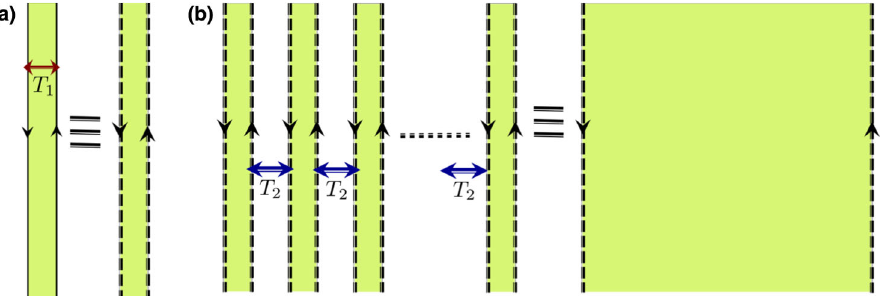
FIG. 3. Array of coupled 1D chain. (a) T 1 represents the intrachain interaction that turns a chain into a parafermion chain. The solid (dashed) line denotes a free-boson (parafermion) gapless mode. (b) T 2 represents the interchain coupling that gaps out every two adjacent parafermion modes. After applying the T 1 and T 2 terms, we are left with a gapped bulk and a chiral gapless parafermion edge